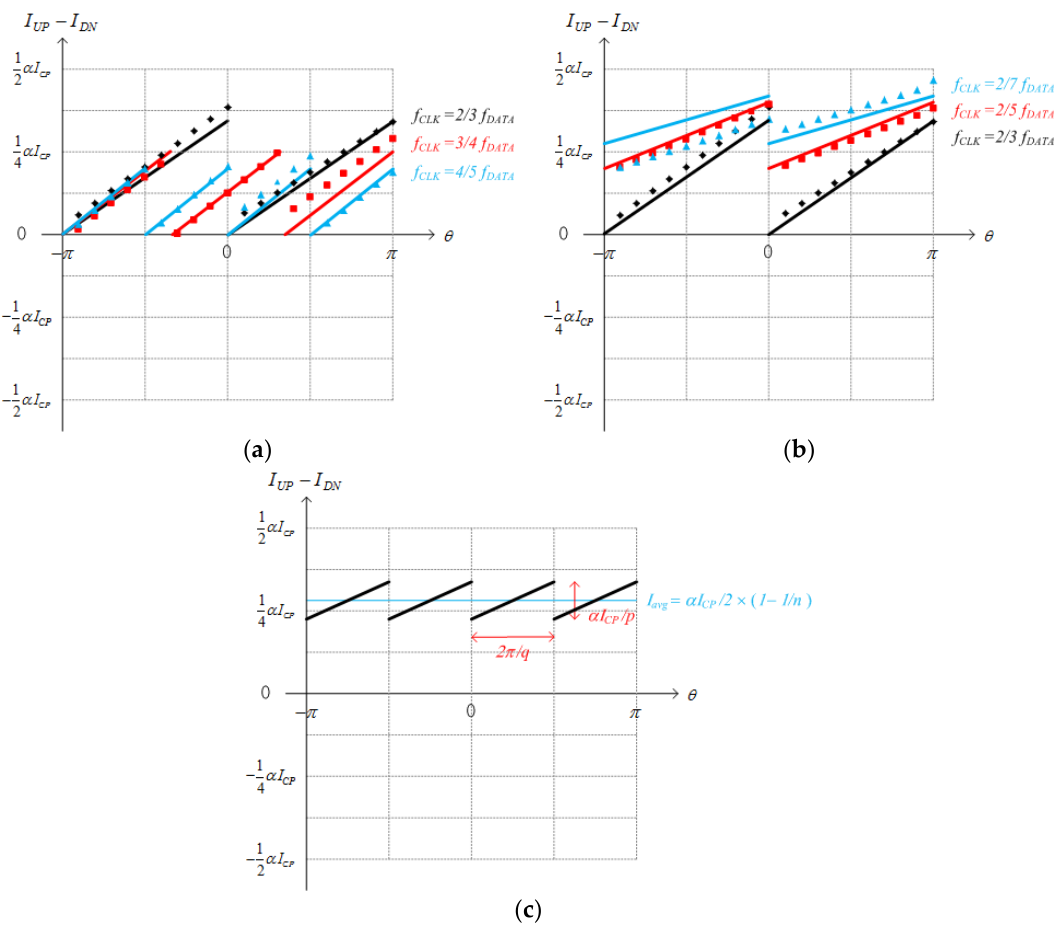
Figure 4. The phase characteristic of the combined full-rate linear PD and charge pump (CP) when f CLK = 1/ n × f DATA and ( a ) n = 3/2, n = 4/3, and n = 5/4; ( b ) n = 3/2, n = 5/2, and n = 7/2; ( c ) n = p / q .